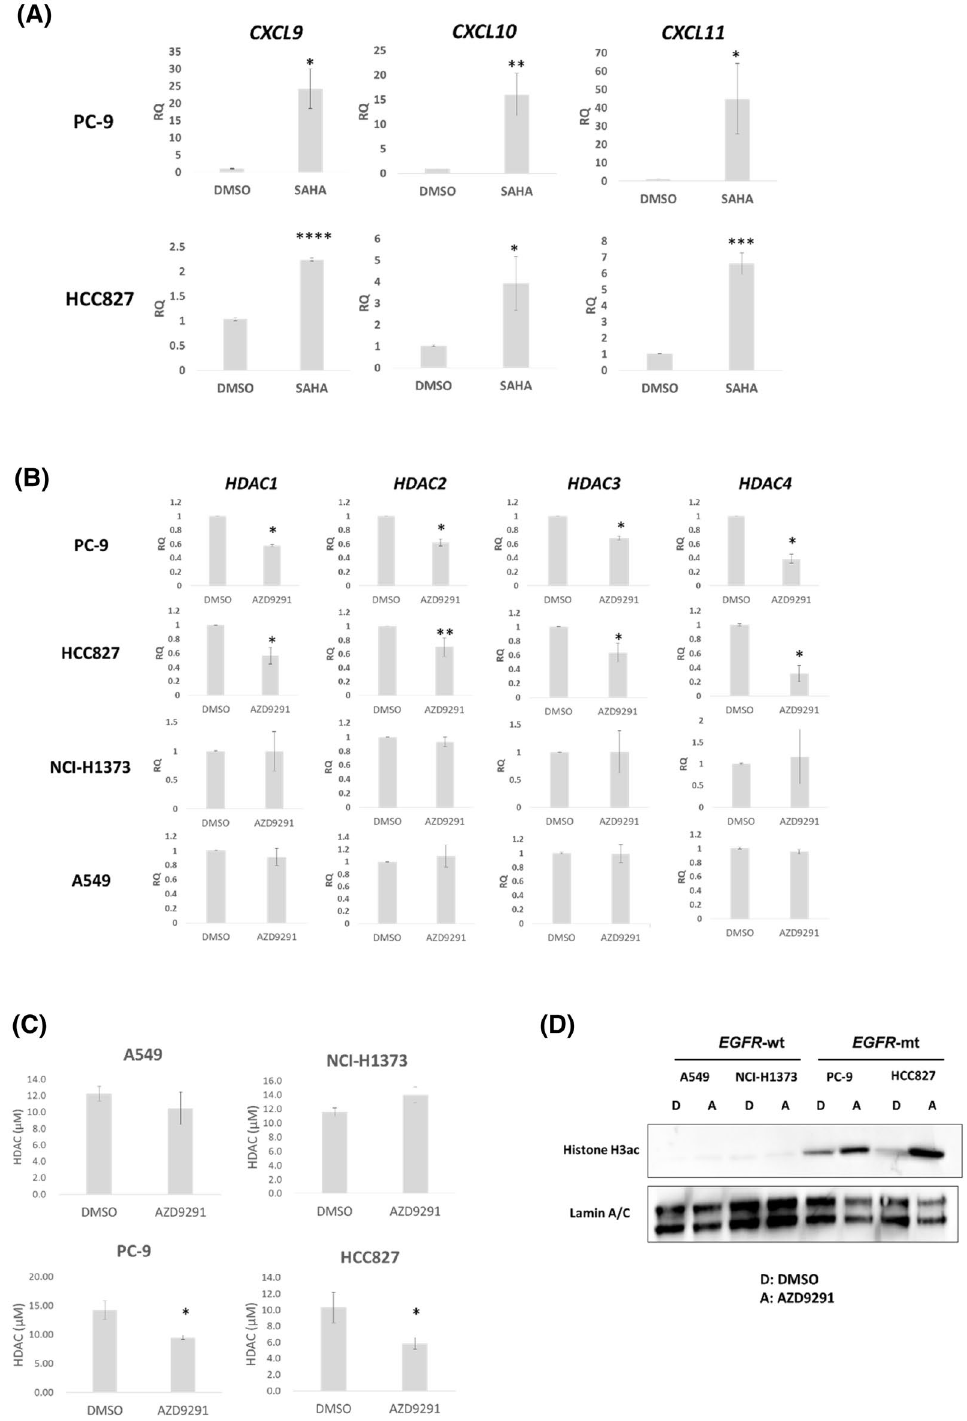
Figure 4. Oncogenic EGFR signaling causes induction of HDAC1 , HDAC2 , HDAC3 , and HDAC4 , associated with increased nuclear HDAC activity, nuclear histone H3 deacetylation, and chemokine suppression in EGFR -mt LA cells. ( A ) RT-qPCR of CXCL9 , CXCL10 , and CXCL11 with or without 10 μM SAHA (vorinostat) in two EGFR -mt LA cells. *p < 0.05, **p < 0.005, ***p < 0.0005, ****p < 0.00005. ( B ) RT-qPCR of HDAC1 , HDAC2 , HDAC3 , and HDAC4 with or without AZD9291 in two EGFR -mt and two EGFR -wt LA cells. *p < 0.01, **p < 0.05. ( C ) Nuclear HDAC activity with or without AZD9291 in the two EGFR -mt and two EGFR -wt LA cells. *p < 0.05. ( D ) Immunoblot of histone H3 acetylation of the nuclear extract with or without AZD9291 in the two EGFR -mt and two EGFR -wt LA cells. LaminA/C is a loading control. All the experiments were performed in biological